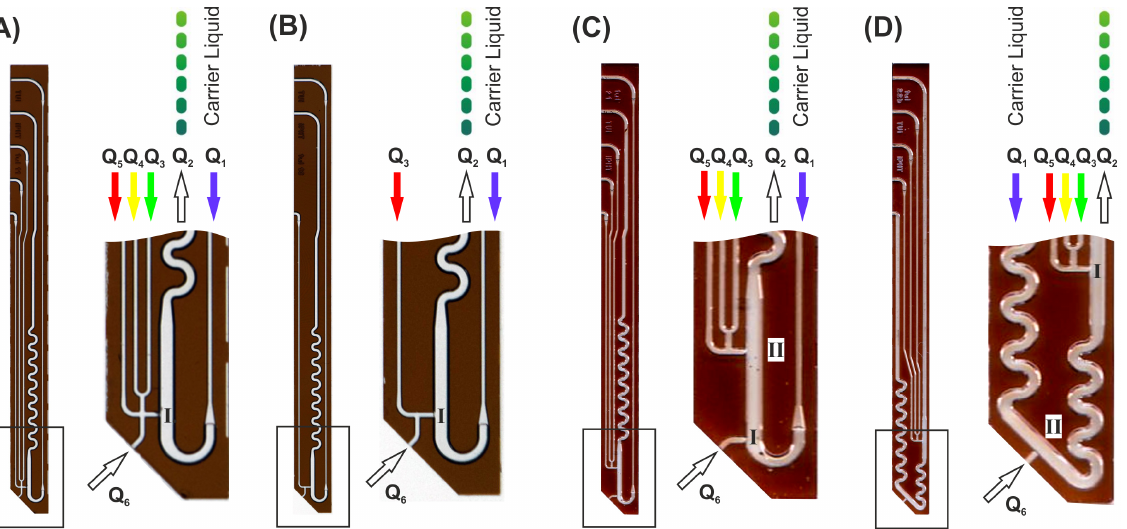
Figure 2. Images of different transfer devices designed for changed droplet formation and effector addition order. Droplets are generated at position I. The addition of the effector or dilution fluids to preformed droplets takes place at position II. Boxed areas are shown as magnification. ( A ) The aspirated sample (Q 6 ) can be mixed with three different effector/dilution liquids (Q 3–5 ) before the stream is injected into the carrier medium for droplet generation. ( B ) This device was designed for single dilution (Q 3 ) of the aspirated sample (Q 6 ) before the droplet generation. ( C ) This device allows the formation of plain sample droplets (Q 6 ) before premixed effector or dilution liquids (Q 3–5 ) are added. ( D ) The device was designed for the initial generation of premixed effector/dilution liquid droplets (Q 1–3 ) prior to the addition of the aspirated sample (Q 6 ). Flow rate Q = dV